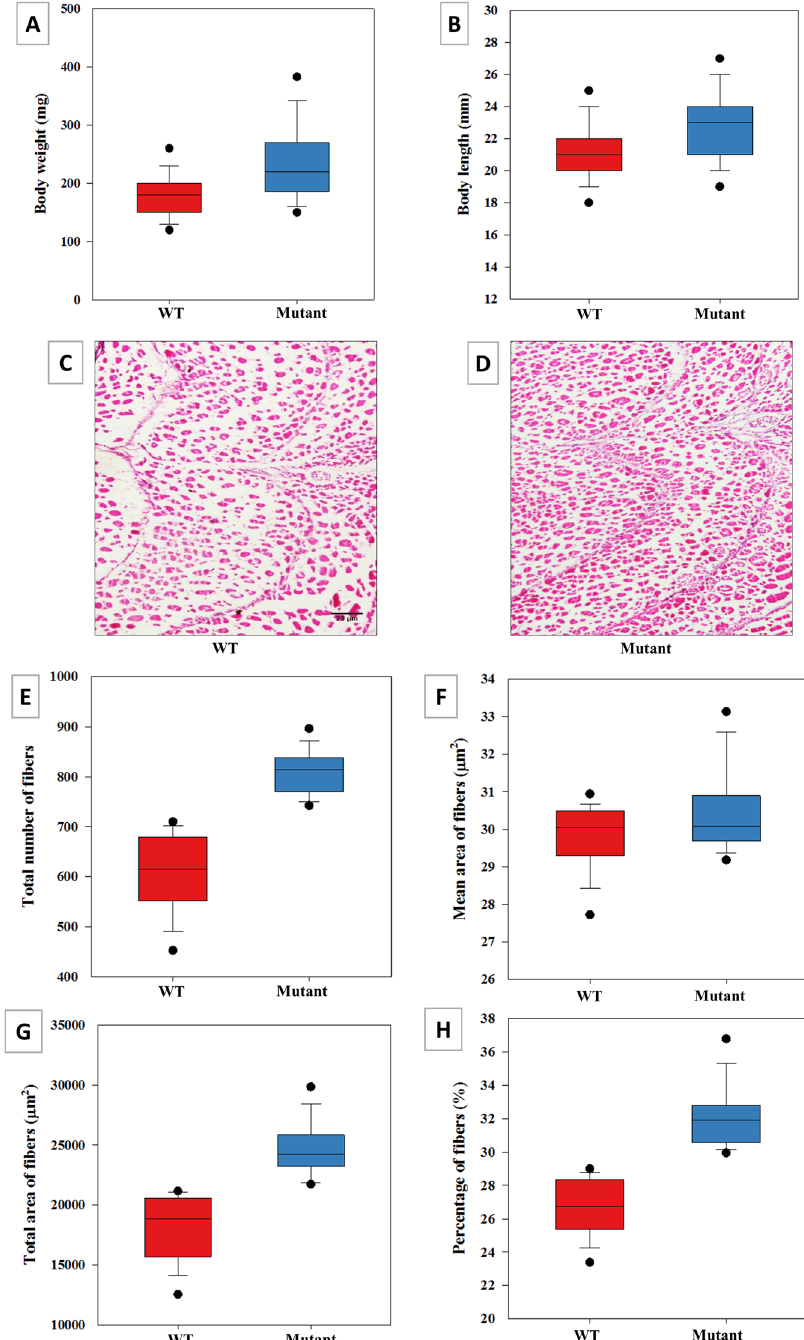
Figure 4. Evaluation of growth in myostatin (MSTN)-mutated one-month-old channel catfish fry. Body weight ( A ) and body length ( B ) of mutant (blue) and wild type (red) ( n = 330). ( C , D ) Representative images of the ventral cross-sectional area of the epaxial muscle of wild-type (WT) ( C ) and mutant (individuals with frame-shift mutation from MSTN-Mix group) ( D ), shown by Hematoxylin and Eosin (H&E) staining. Scale bar in ( C , D ): 25 µ m. Numbers of muscle fibers ( E ), the average area of the muscle fibers ( F ) and the total area of fibers ( G ) of mutant (blue) and wild-type (red), quantified H&E staining images (see C , D ) with ImageJ. Approximately 32 stained images for each treatment were quantified. Distribution percentage of the fibers ( H ) was calculated as the total area of fibers per cross-sectional area multiplied by 100. Statistical significance was set at p < 0.05, and all data were presented as the mean ± standard error ( SEM